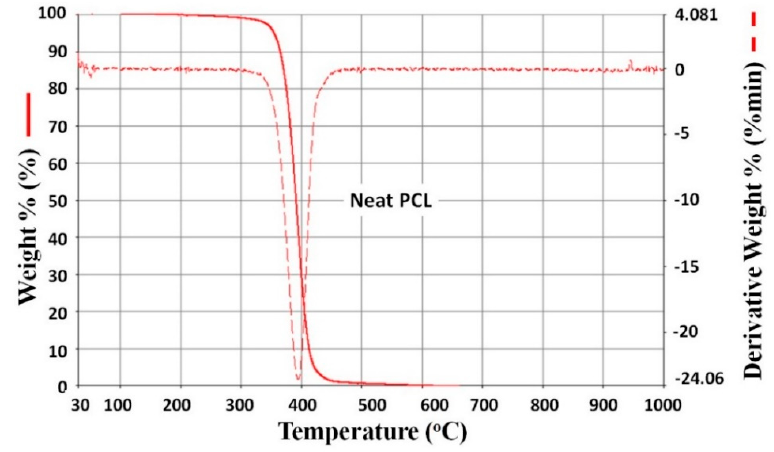
Figure 6. Thermogram of pure polycaprolactone polymer.